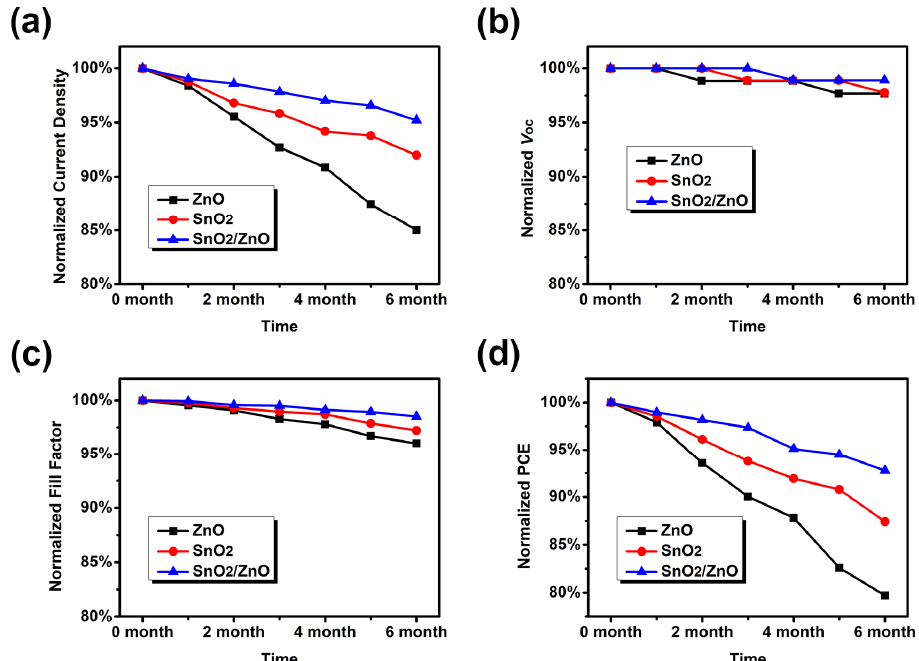
Figure 5. The normalized photovoltaic performance curves of devices in purity nitrogen atmosphere: ( a ) for J SC ; ( b ) for V OC ; ( c ) for FF; ( d ) for PCE.